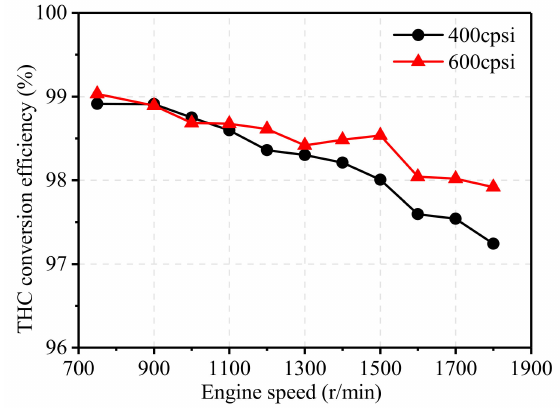
Figure 18. E ff ect of pore density on THC conversion e ffi